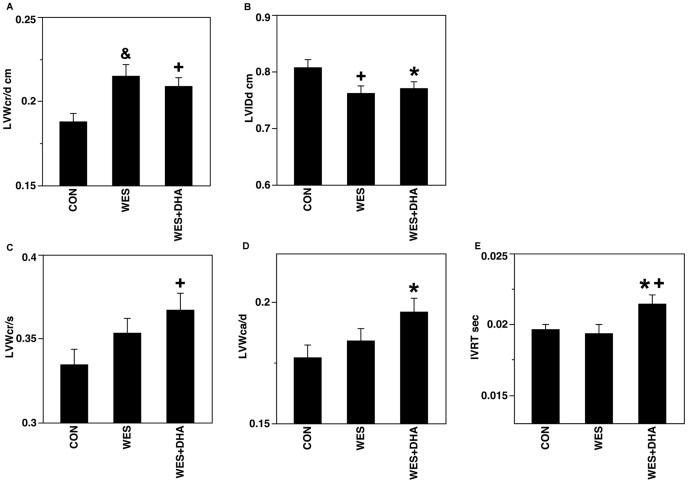
Echocardiographic indices that were different according to high-fat feeding (i.e. WES and WES+DHA; A and B) and to WES+DHA feeding alone (C–E).A,B: Both WES and WES+DHA rats had greater LVWcr/d (A) and reduced LVIDd (B) compared to CON. C, D: WES+DHA feeding was associated with greater LVWcr/s (C) and LVWca/d (D) compared to CON. E: WES+DHA rats had prolonged IVRT compared to both CON and WES. (*p<0.05; +p<0.01; &p<0.001).